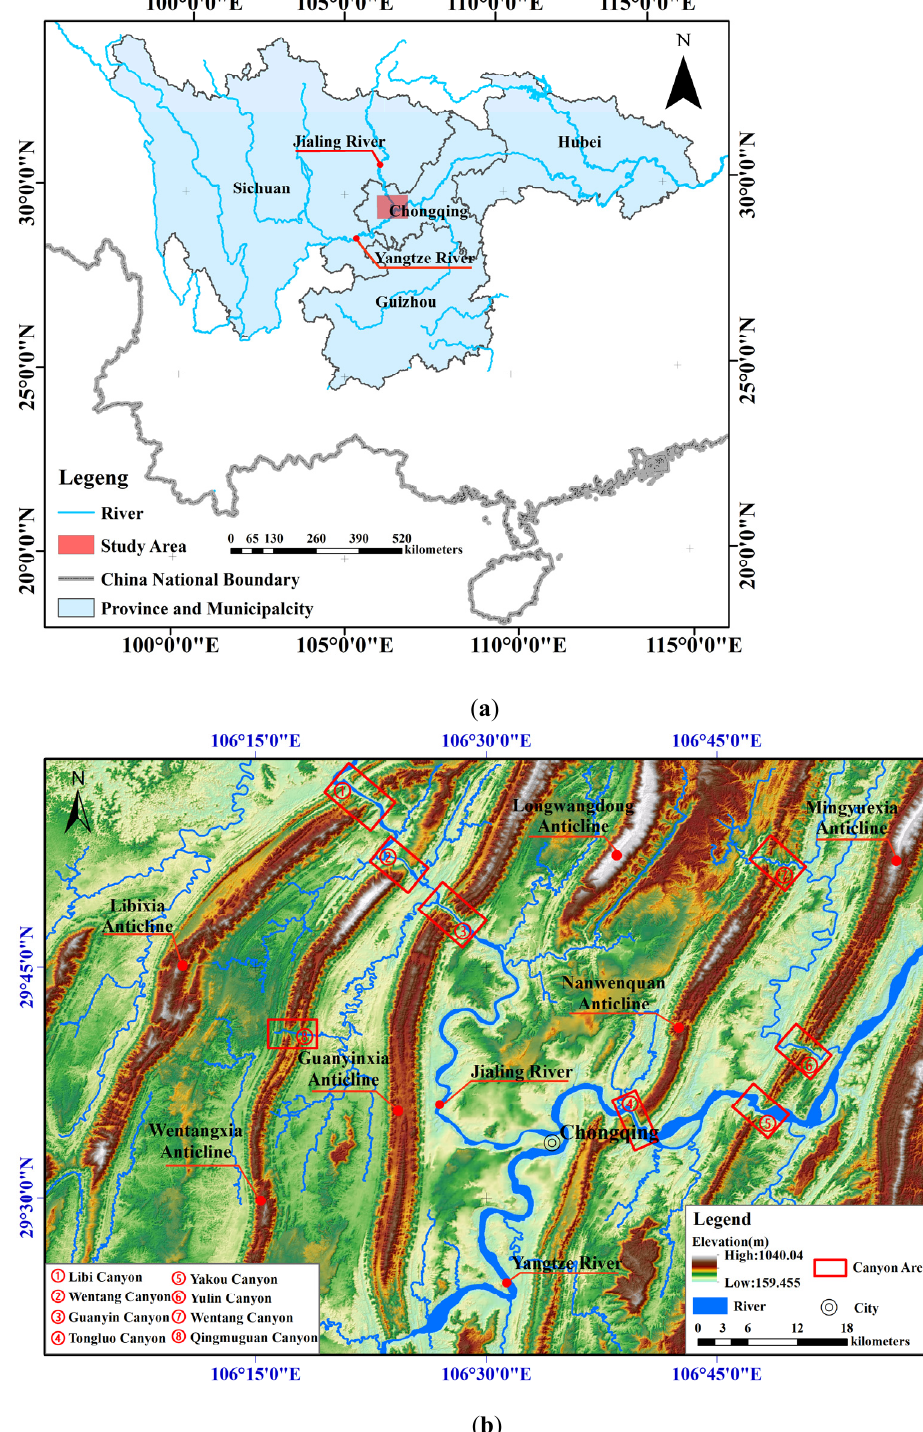
Figure 3. Study region surrounding Chongqing city. ( a ) The location of the study region; ( b ) the input dataset, including the DEM and vector river data.